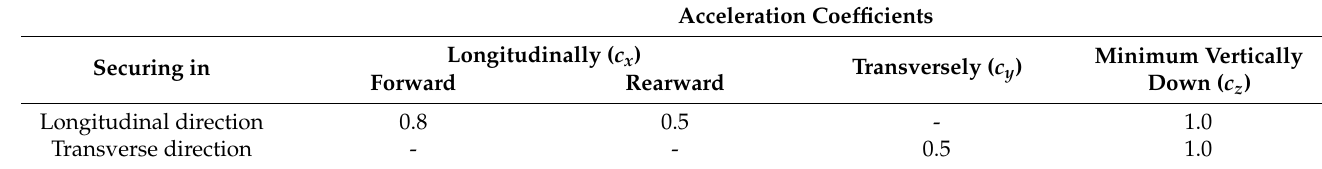
Table 2. Applicable acceleration coefficients for road transport